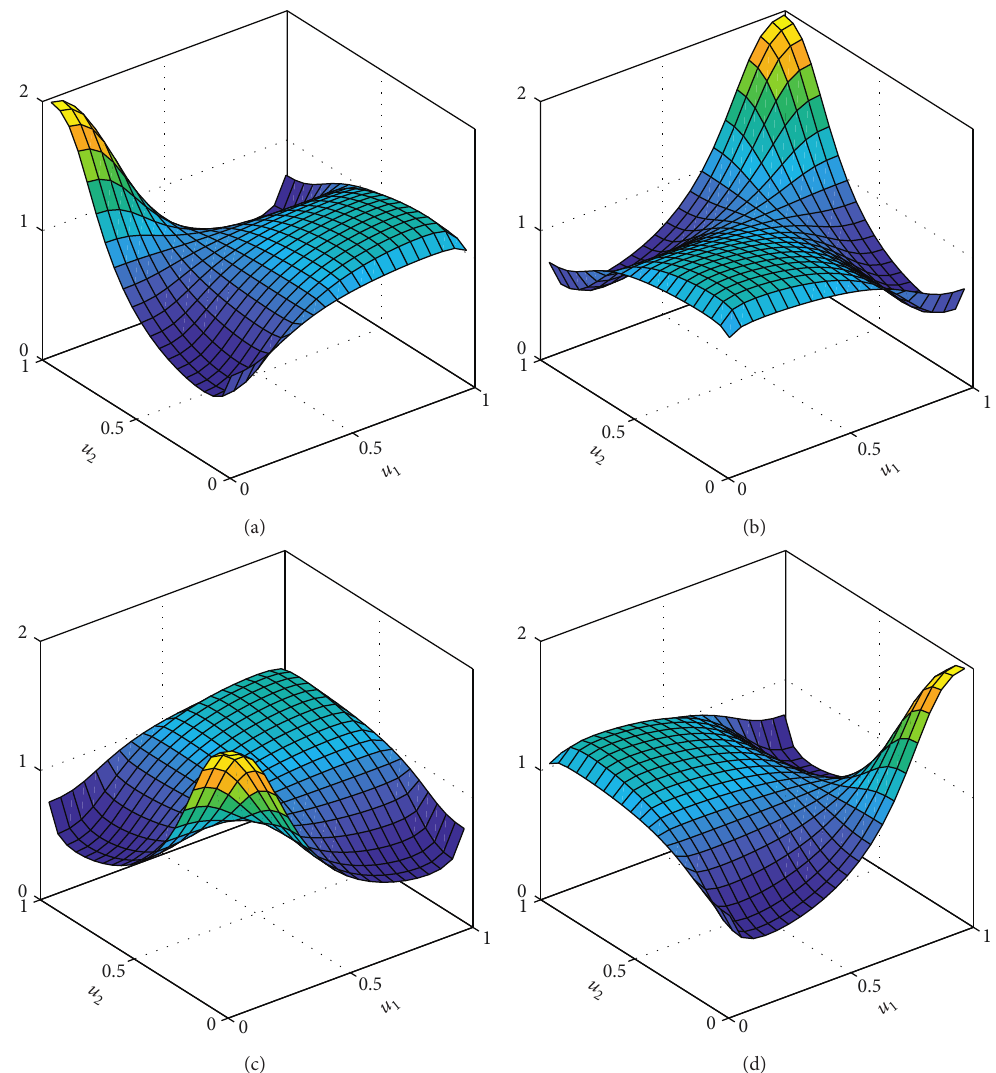
Figure 2: The bivariate NCCN copula density function. (a) c